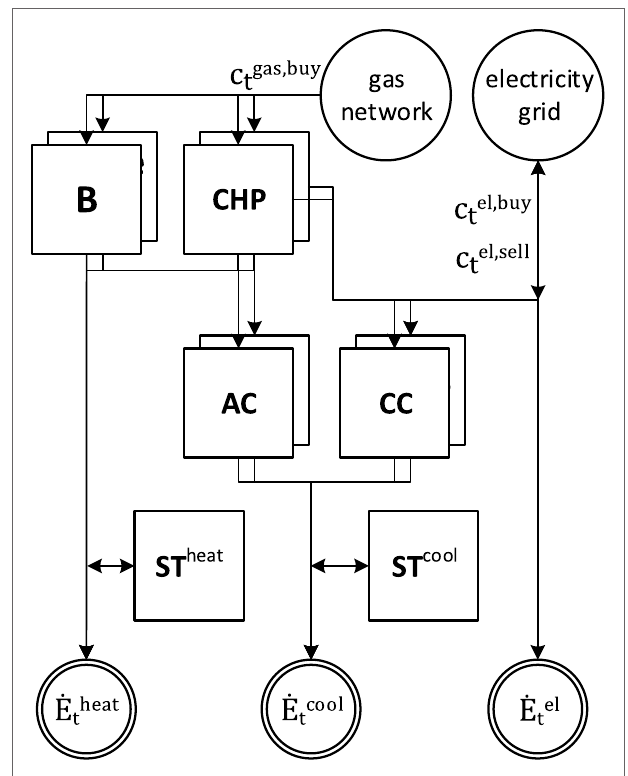
FIGURE 4 | Superstructure of real-world example based on Voll et al. (2013): boiler (B), combined heat and power unit (CHP), compression chiller (CC), and absorption chiller (AC) extended by thermal storage (ST) with variable capacity for cooling and heating. Time series ( Figure 5 ) of volatile energy prices c t and energy demands ˙ E t are